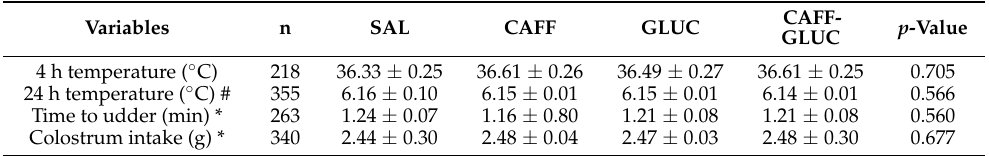
Table 1. Rectal temperatures at 4 and 24 h ( ◦ C), time to udder (min), and colostrum intakes (g) for piglets allocated to oral treatments at birth groups; saline (SAL), caffeine (CAFF), glucose (GLUC) and caffeine plus glucose (CAFF-GLUC). Variables n SAL CAFF GLUC CAFF- GLUC p -Value 4 h temperature ( ◦ C)